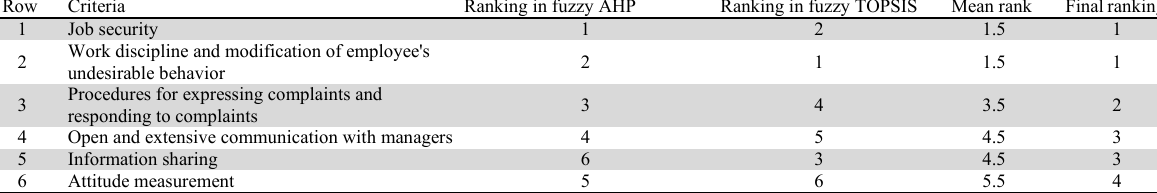
The results of final ranking of employee's communication sub-criteria